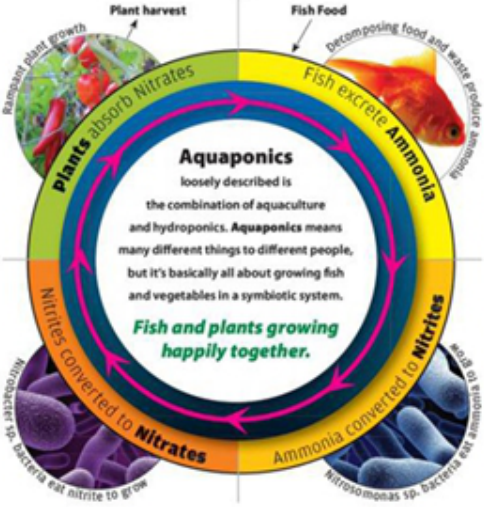
Figure 1. The nitrogen cycle in an aquaponics system (Aquaponics Plans,